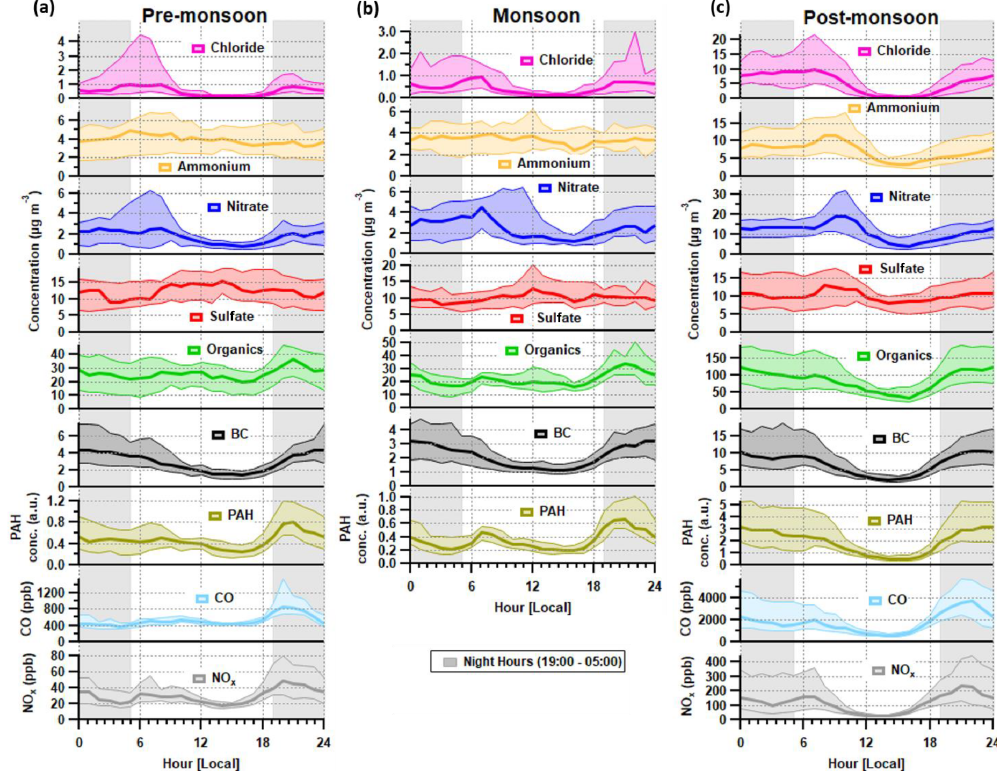
Figure 2. Median diurnal cycles for aerosol chemical species and for BC, CO and NO x during the (a) pre-monsoon, (b) monsoon and (c) post-monsoon periods. The median concentration is represented by the thick line, and the interquartile range is represented by the shading. Regions shaded in grey are night hours. Data for CO and NO x are not available for the monsoon period.